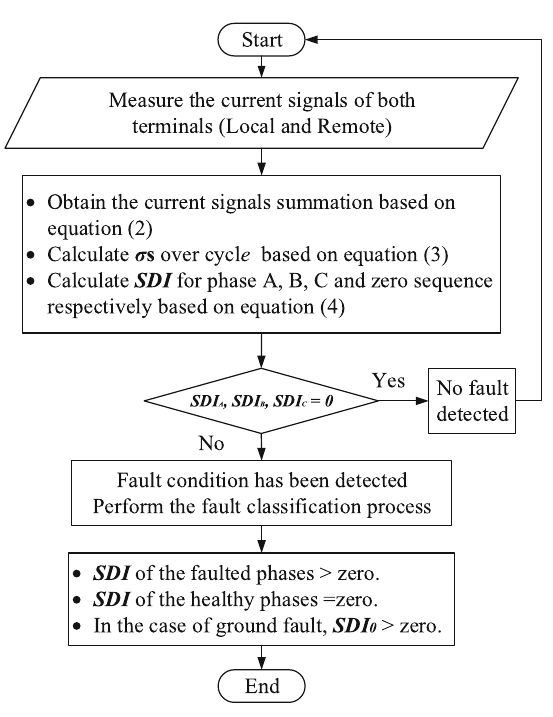
Fig. 1 Flow chart of the proposed